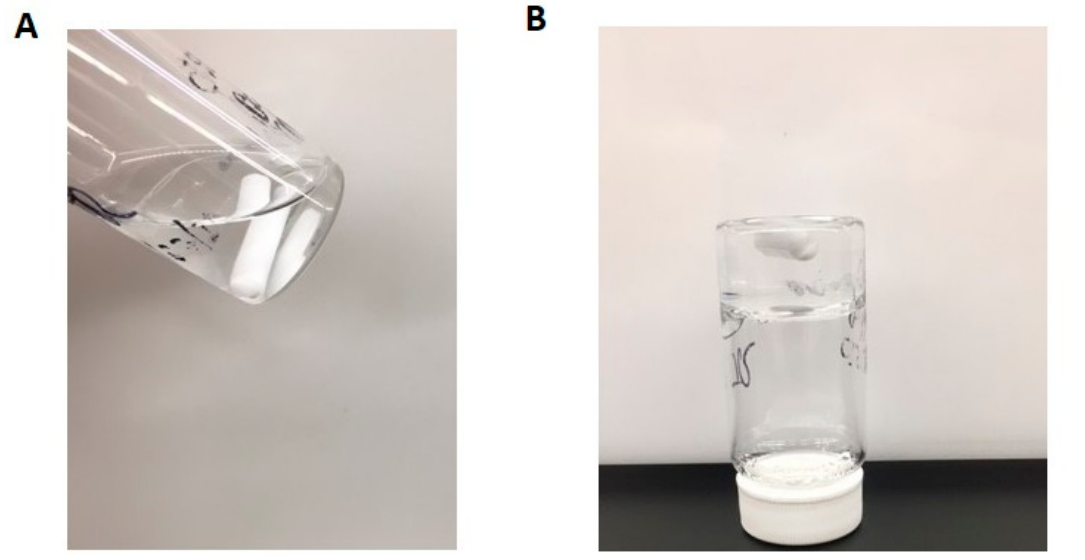
Figure 1. Solution of 20% w/w poloxamer 407 in water ( A ) at 4 °C prior to heating and ( B ) after heating on a stir plate until gelation occurred, causing the stir bar to stop moving.